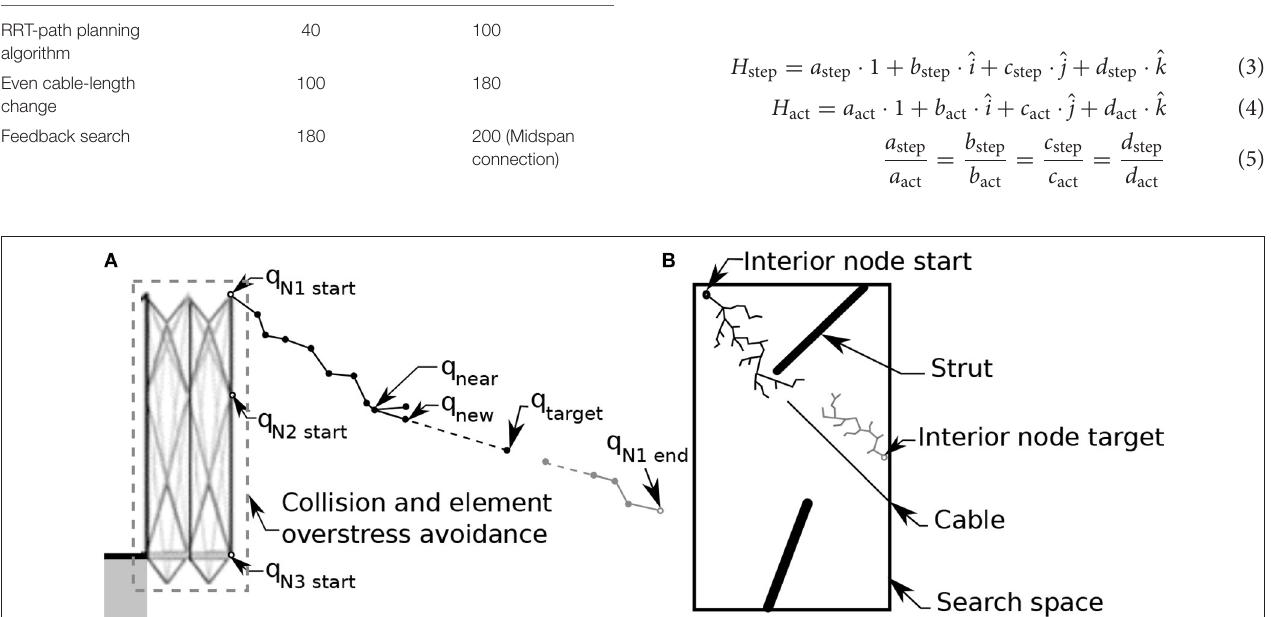
FIGURE 5 | Path of an end-node is shown for collision and over-stress avoidance. A sample longitudinal 2D-section of the tensegrity structure (A) shows the RRT*-connect algorithm navigation around structural elements possible in three dimensions. A schematic of the RRT*-connect algorithm notation for one step (B) . Successful points for two trees, one from the start point and one from the end, are shown in black and gray respectively.